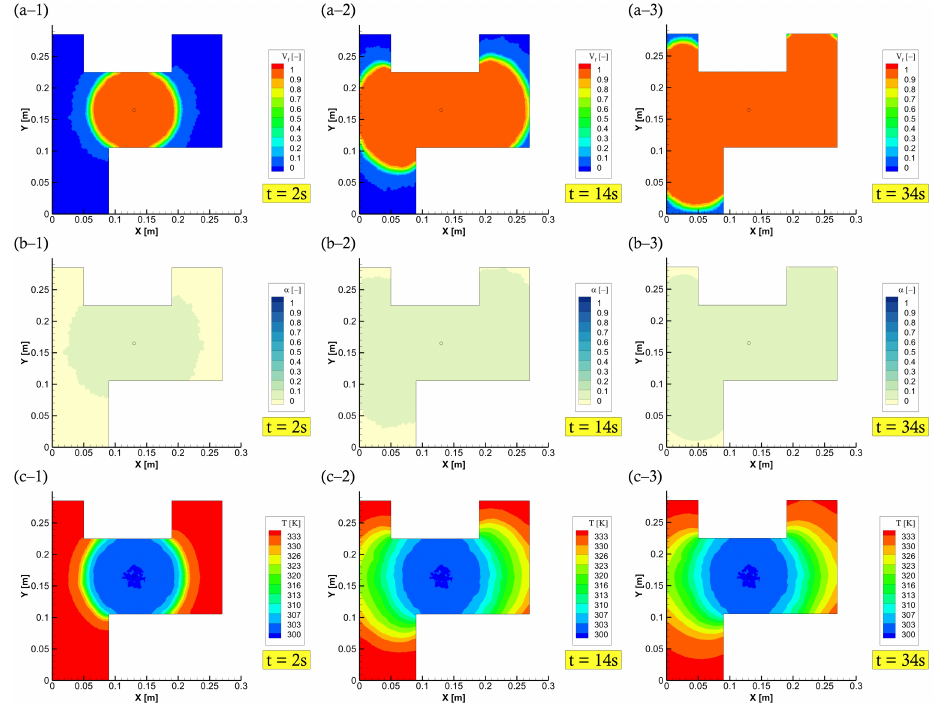
Figure 7. The simulation results related to the mould filling process: ( a ) resin impregnation and flow front; ( b ) degree of cure; and ( c ) temperature